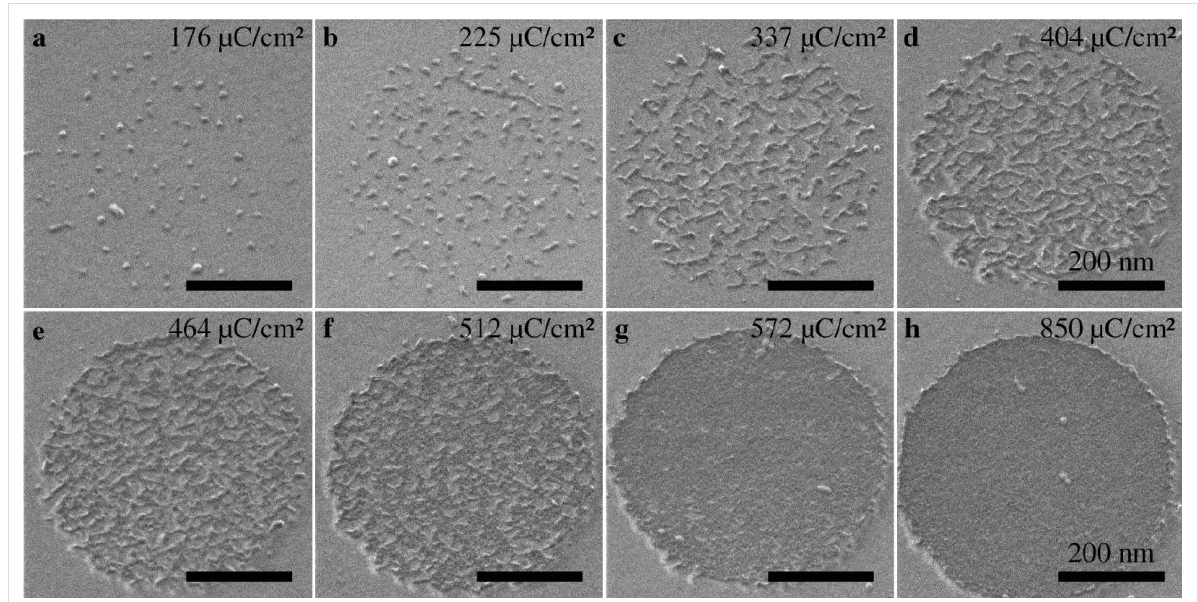
Figure 3: A series of HIM images showing the cross-linking of a NBPT SAM induced by helium ion irradiation, where the cross-linked SAM was trans- ferred onto a SiO 2 /Si substrate after being cross-linked within a circular region with the dose given in the upper right corner of each image: (a) forma- tion of circular shaped nuclei which are widely separated and randomly distributed. (b) more nuclei come into being and some of them start to grow one dimensionally; (c) chainlike structures with a typical length of ca. 100 nm become the majority; (d) chain thickening indicates a two-dimensional (2D) growth beginning to take place; (e–f) 2D growth plays a dominating role; (g) the CNM contains tiny holes; (h) the CNM forms completely and no defects are observed, indicating the status of a complete cross-linking. The scale bars are 200